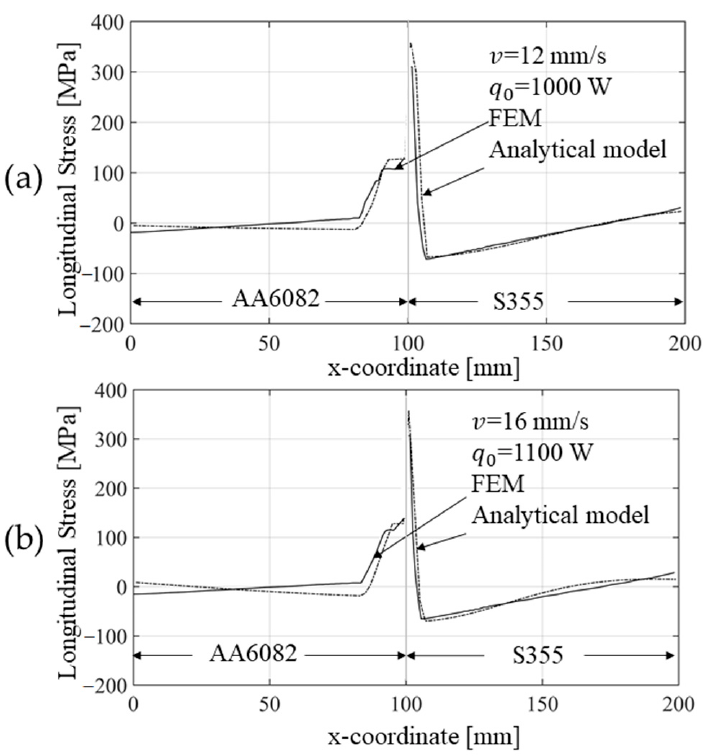
Figure 13. ( a ) Comparison between the residual longitudinal ( y direction) stress calculated with the two methods (i.e., FEM and analytical model), considering a cross section taken at the mid-length of the plates and for a welding speed of 12 mm/s and a power input of 1000 W. ( b ) Comparison between the residual longitudinal stress calculated with the two methods (i.e., FEM and analytical model), considering a cross section taken at the mid-length of the plates and for a welding speed of 16 mm/s and a power input of 1100 W.